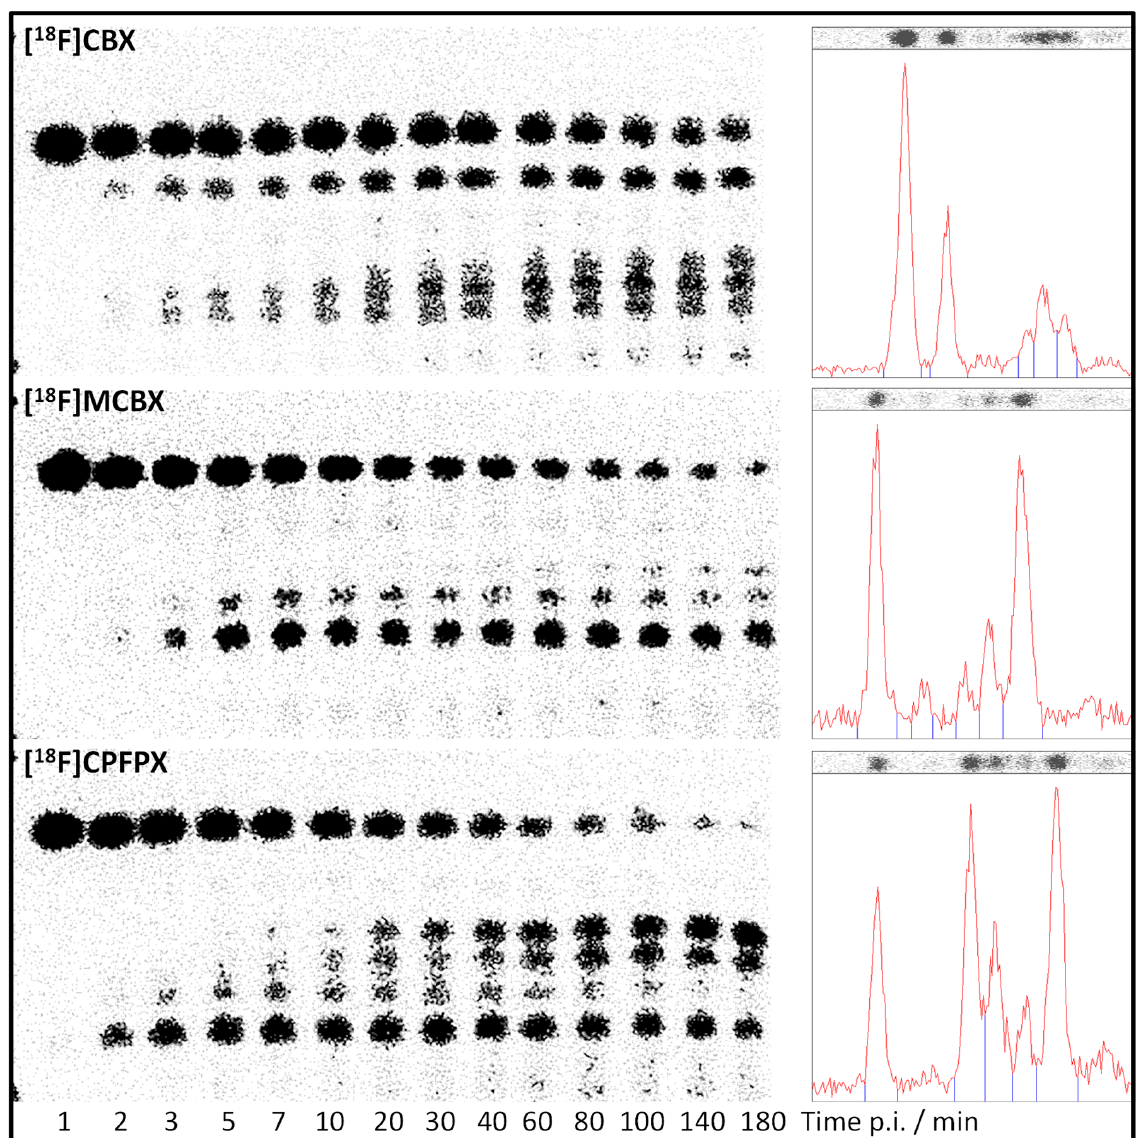
Figure 6. In vivo metabolite profiles of [ 18 F]CBX, [ 18 F]MCBX, and [ 18 F]CPFPX obtained from rat plasma. Left panels: radio-TLC images (SIL G-25 plates); right panels: corresponding densitometer scans at 60 min post-injection.